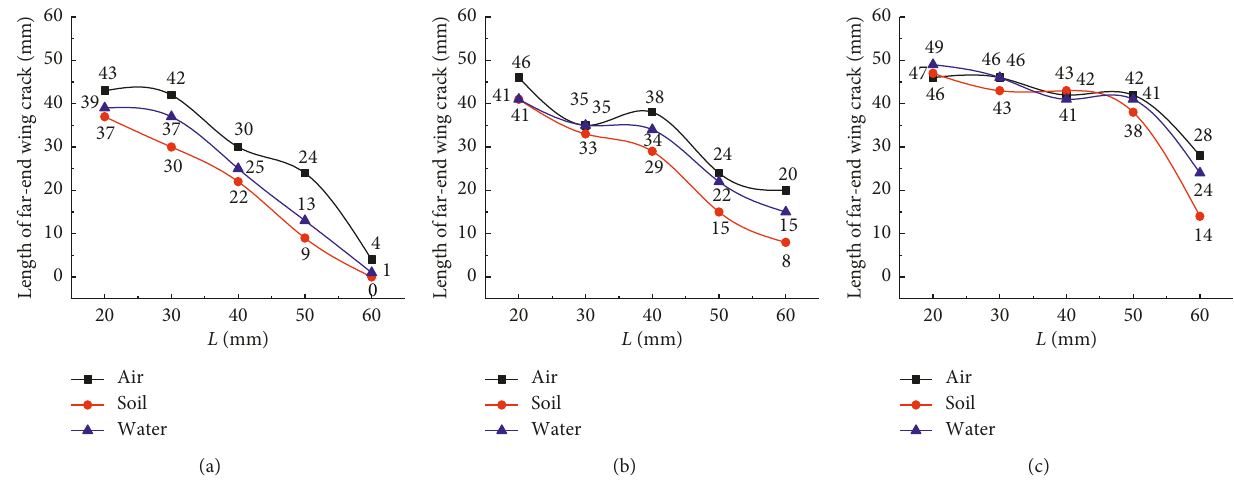
Figure 20: Relationship between fillings and length of far-end wing crack. (a) θ � 0 ° ; (b) θ � 45 ° ; (c) θ � 90 °